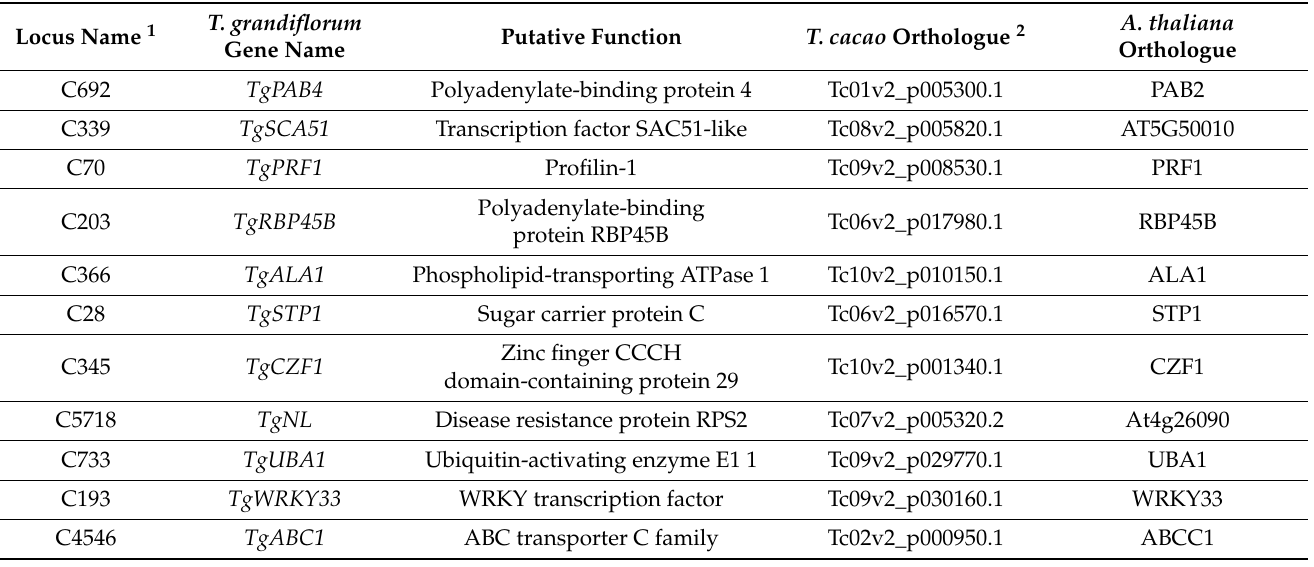
Table 2. Theobroma grandiflorum genes used in this study and their orthologues in T. cacao and A. thaliana